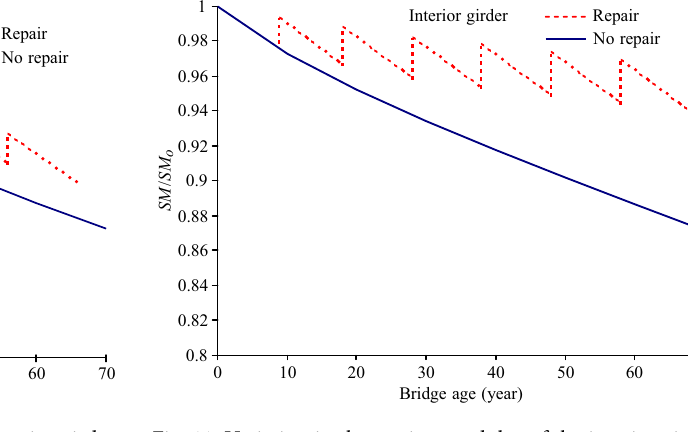
Fig. 11. Variation in the section modulus of the interior girder of the bridge with age